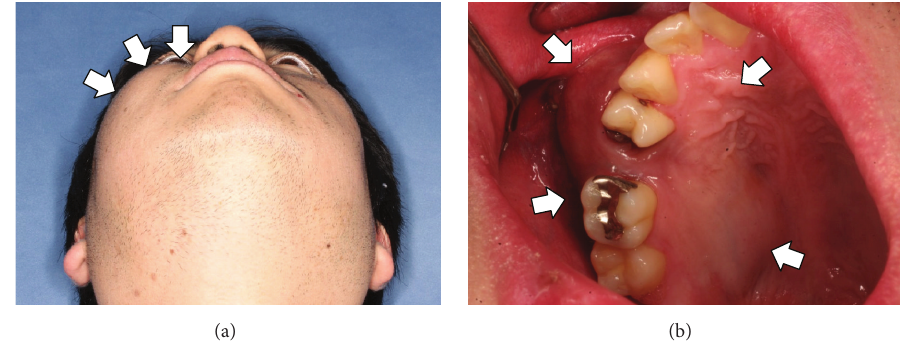
Figure 1: Extraoral (a) and intraoral (b) photographs show diffuse swelling in the right cheek and maxillary alveolar region (arrows).